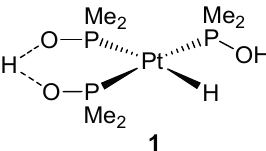
Figure 1. Structure of the nitrile hydration catalyst [PtH{(PMe 2 O) 2 H}(PMe 2 OH)] ( 1